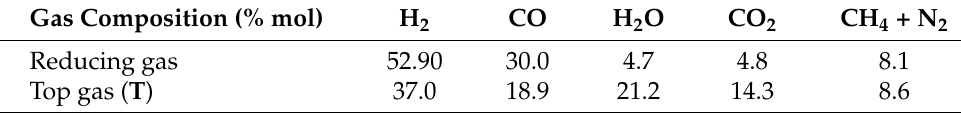
Table 1. Compositions of inlet and outlet gases of the Midrex shaft in Gilmore plant.